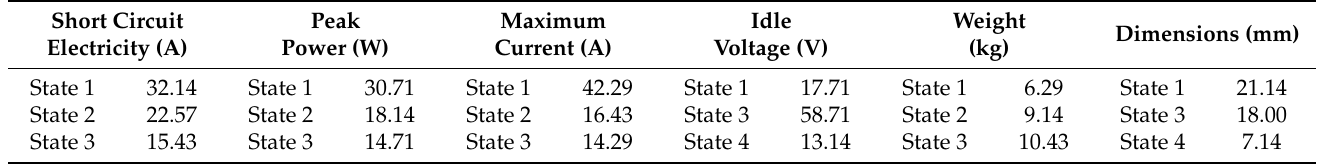
Table 6. Results from ACO for the most favorable order of modification of the PV criteria